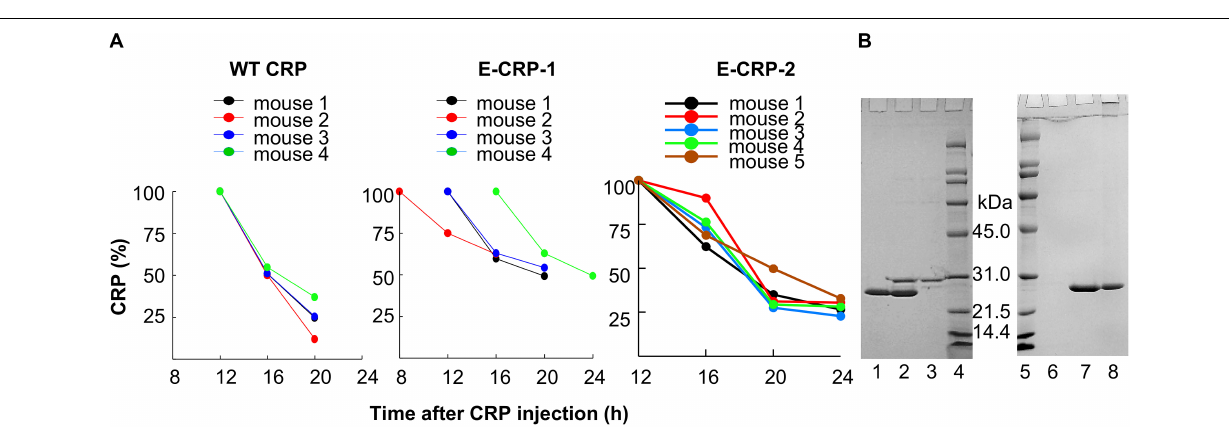
be repurified from E-CRP-spiked mouse serum ( Figure 4B ). As shown (left panel), E-CRP-1 present in the mouse serum bound to PEt in a Ca 2 + -dependent manner and could be eluted with EDTA (lane 2). The recovery of E-CRP-1 was 96%. Besides CRP,